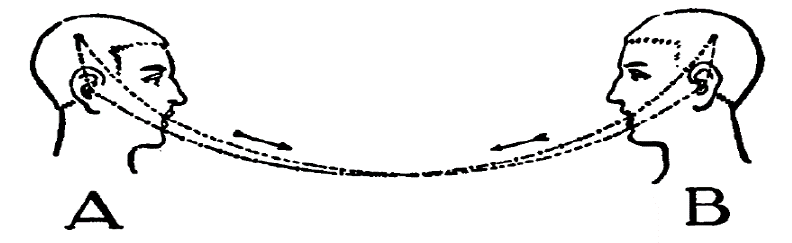
Figure 2: Components of Communication Process (Sender-Receiver) Bühler